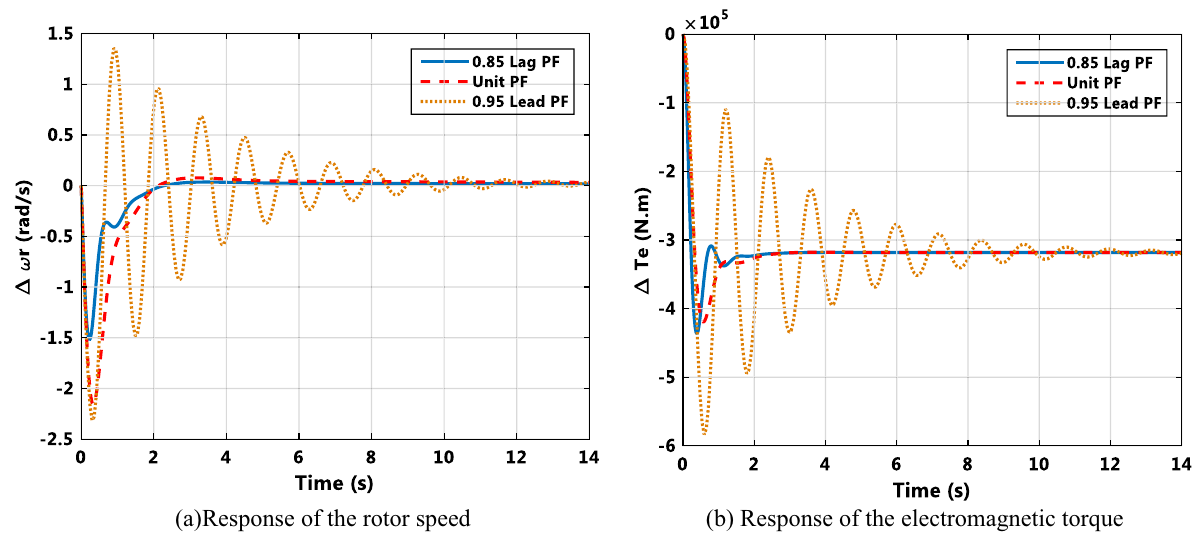
Fig. 12 Step response of speed and electromagnetic torque at different